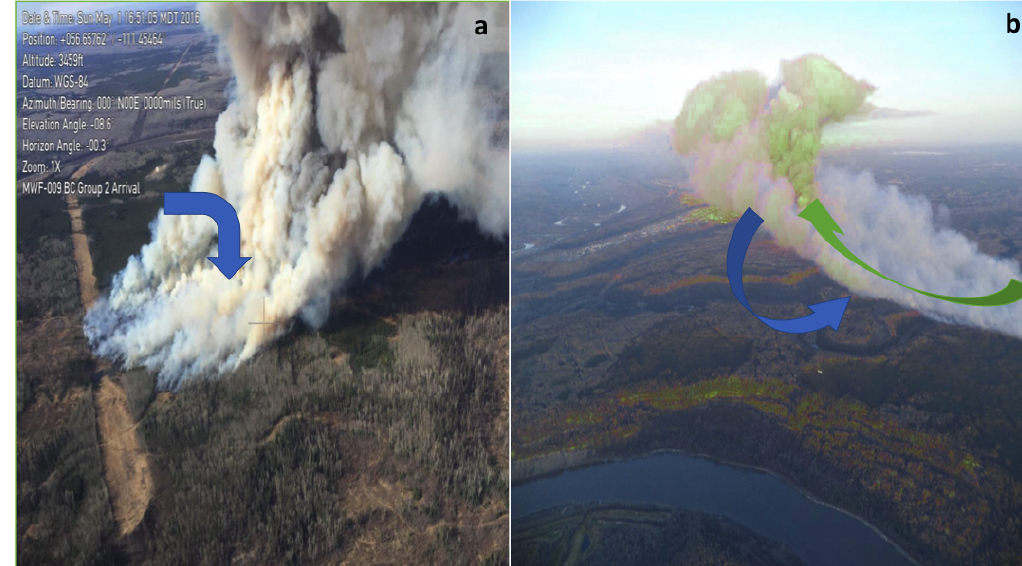
Figure 12. Horse River fire at 16:51 MDT, May 1, 2016 (less than one hour after detection). Fire Images are courtesy from MWF-009-16, Alberta Parks report. ( a ) West view of Horse River fire (May 1, 2016 23:51), ( b ) east view of Horse River fire, with green shade to demonstrate the strong updraft area. The blue arrows are the illustration of downdrafts and green arrow shows